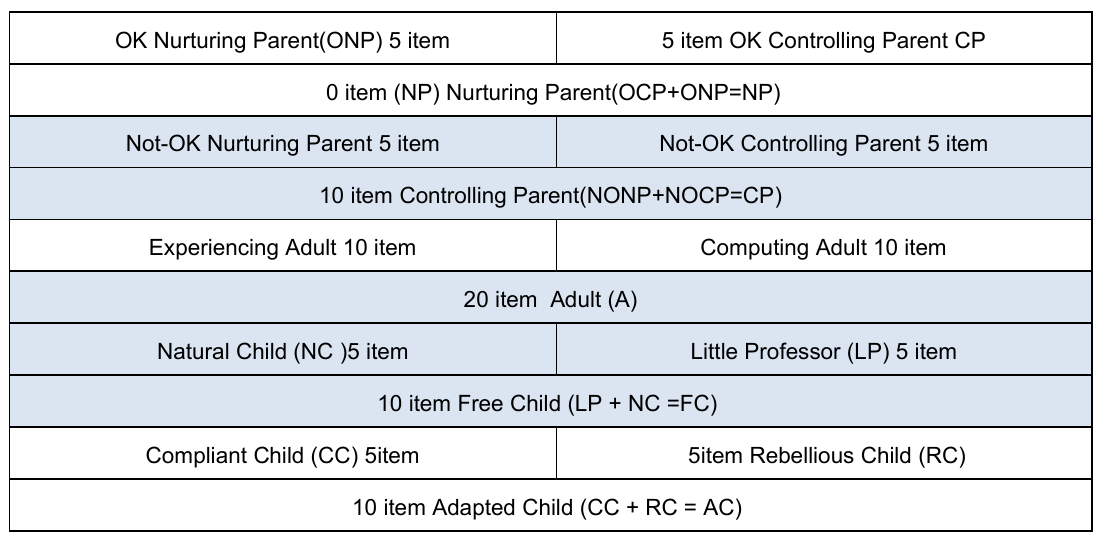
Table 2: The Ego State Wheel